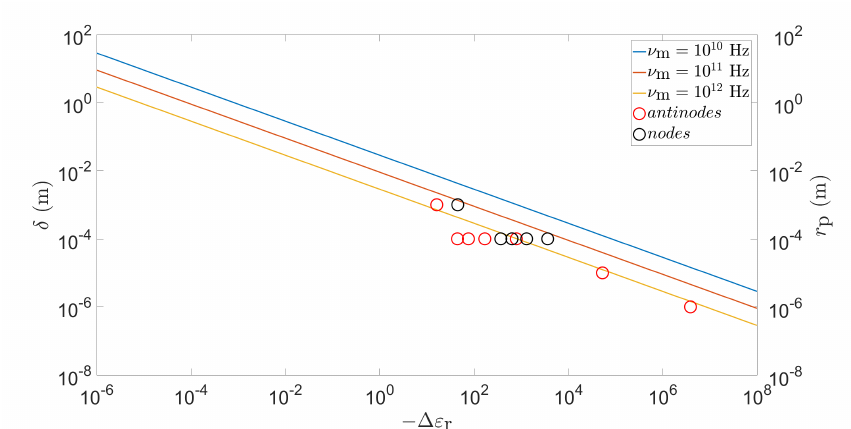
Figure 16. The skin depth of a plasma for three collision frequencies as a function of the change in permittivity ∆ ˜ ε with respect to ε 0 . Furthermore, the parameters in which the shift of the resonance frequency no longer scales linearly with a change in permittivity are indicated by circles for a variety of modes—red circles for plasma at an antinode and black circles for at a node—and plasma